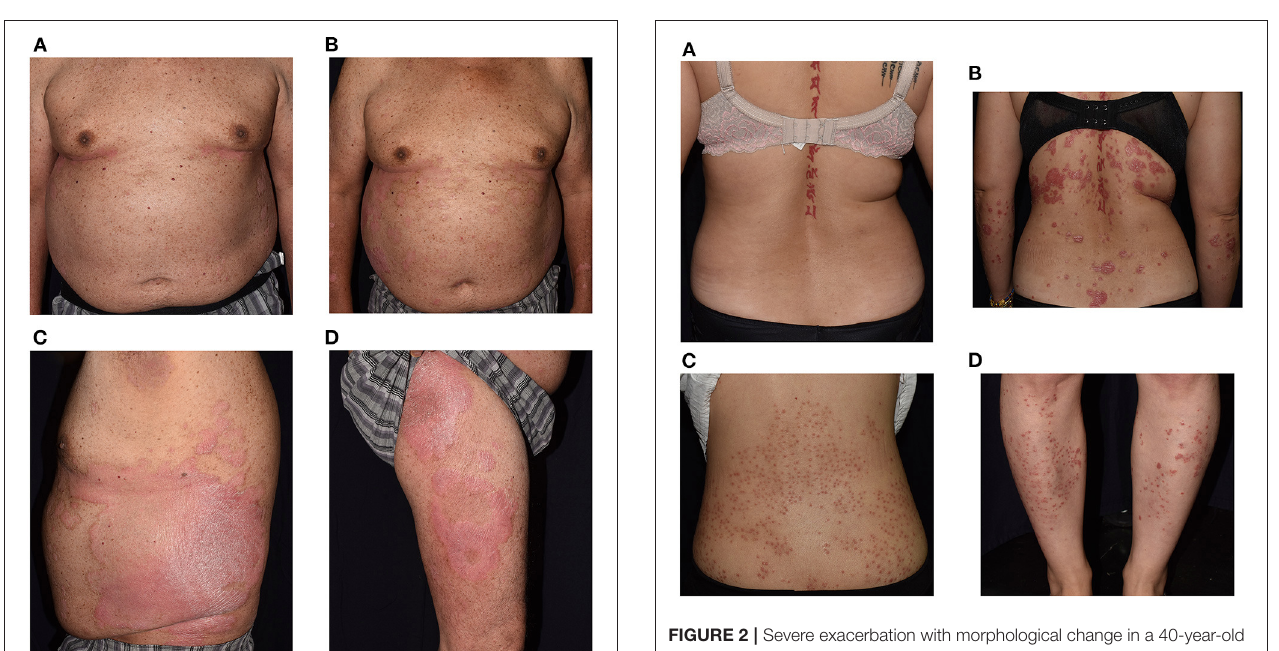
4 (13%) have diabetes mellitus, and 4 (13%) hepatitis B virus infection in the unvaccinated group. None of the patients in